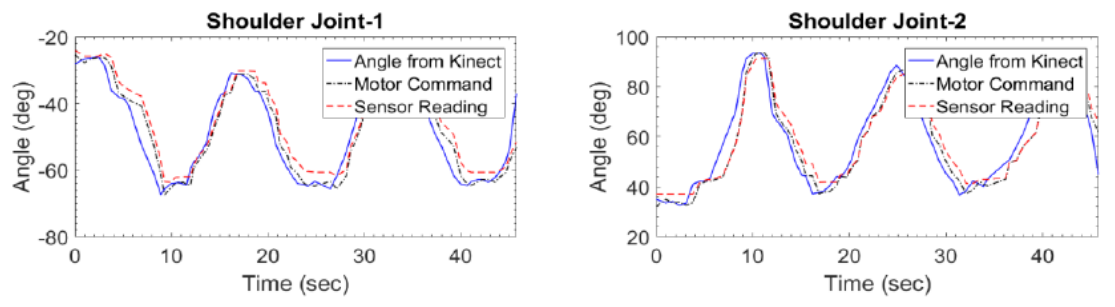
Figure 16: Shoulder joint horizontal flexion/extension teleoperation. comparison between joint angles from Kinect and NAO robot